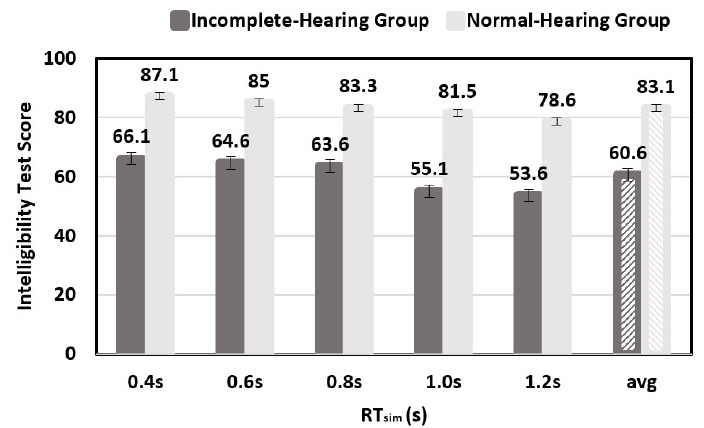
Figure 11. Speech intelligibility test results of RT sim .